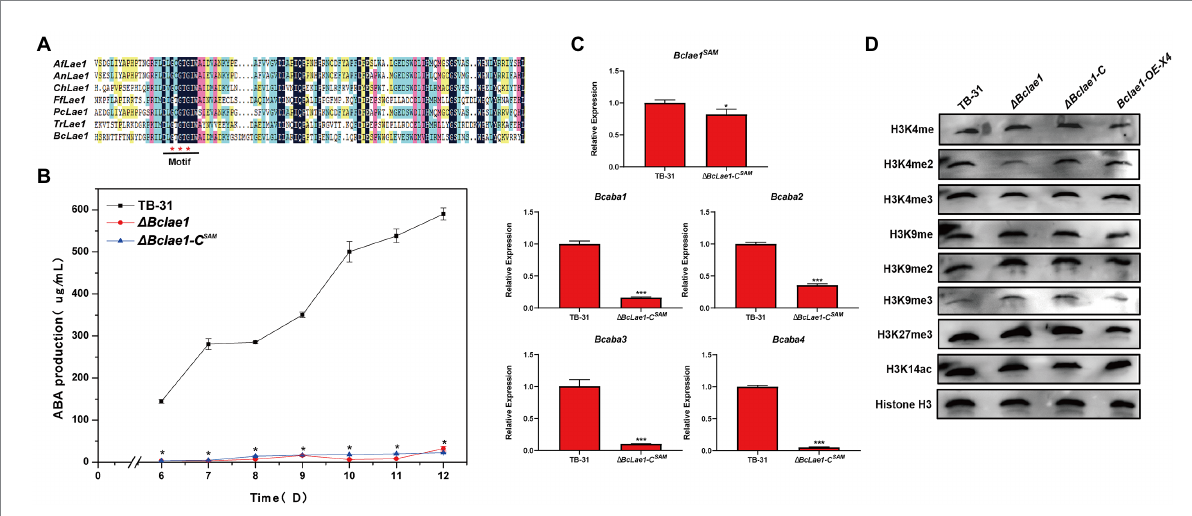
FIGURE 6 The SAM domain of BcLAE1 is essential for its full activity. (A) Multiple sequence alignment of the LaeA/ LAE1 SAM domain from Aspergillus fumigatus LaeA, Aspergillus nidulans LaeA, Cochliobolus heterostrophus LAE1, Fusarium fujikuroi LAE1, Cochliobolus heterostrophus LAE1, Trichoderma reesei LAE1, and B. cinerea LAE1. Black, pink, blue, and yellow represent 100%, greater than 75%, greater than 50%, and greater than 30% homology levels, respectively. The red * marked the glycine that was replaced for alanine. (B) The TB-31, Δ Bclae1 mutant, and Δ Bclae1 -C SAM mutant were grown on PDA. Samples for the quantitative determination of ABA production were collected at 6–12 days. The error bars indicate the standard errors of the mean for three replicate cultures ( n = 3). Asterisks indicate significant differences in ABA production between selected mutants and TB-31 ( p < 0.05). (C) RT-qPCR examining the transcriptional levels of ABA gene cluster and Bclae1 in Δ Bclae1 -C SAM and TB-31. The relative transcriptional levels of selected genes were obtained after normalization to the constitutive tubulin reference gene (BC1G_05600) at 6 days. The relative values for selected genes transcription at 6 days in TB-31 were arbitrarily assigned as 100%. Shown are means and SEM, n = 3 independent biological replicates. * p < 0.05/*** p < 0.001 versus the same genes of the TB-31 group. (D) Western blots for H3K4me1/2/3, H3K9me1/2/3, H3K27me3, and H3K14ac global status in the histone extracts isolated from the 6 days cultures of the TB-31, Δ Bclae1 , Δ Bclae1 -C (X7), and Bclae1 -OE-X4 mutants. Anti-H3 was used as a loading